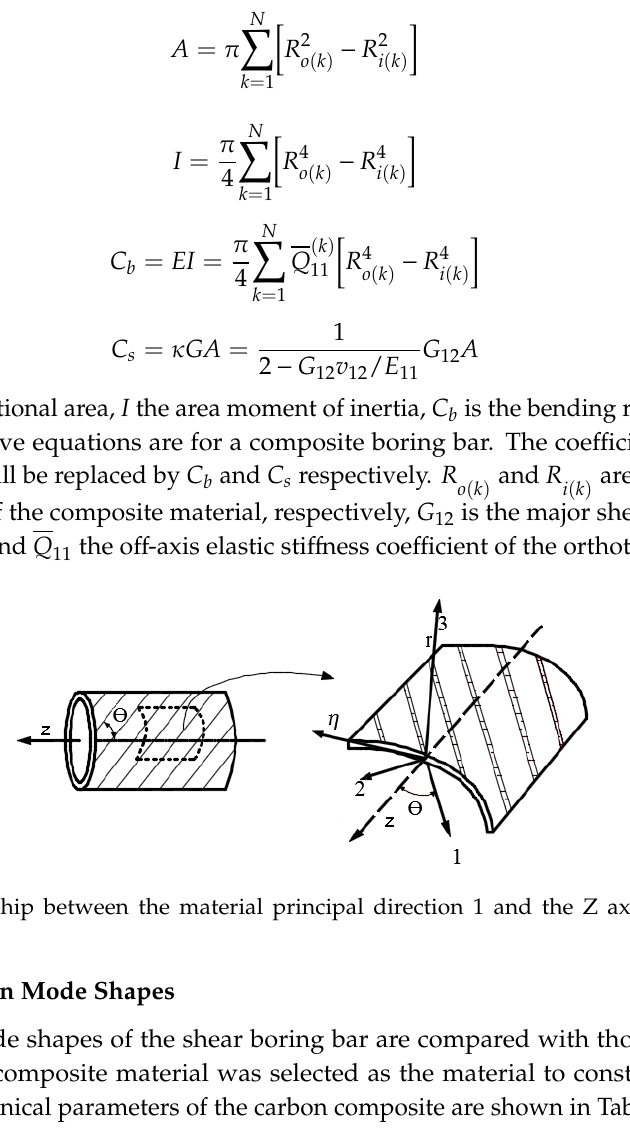
Table 2. Macroscopic mechanical parameters of composite materials.